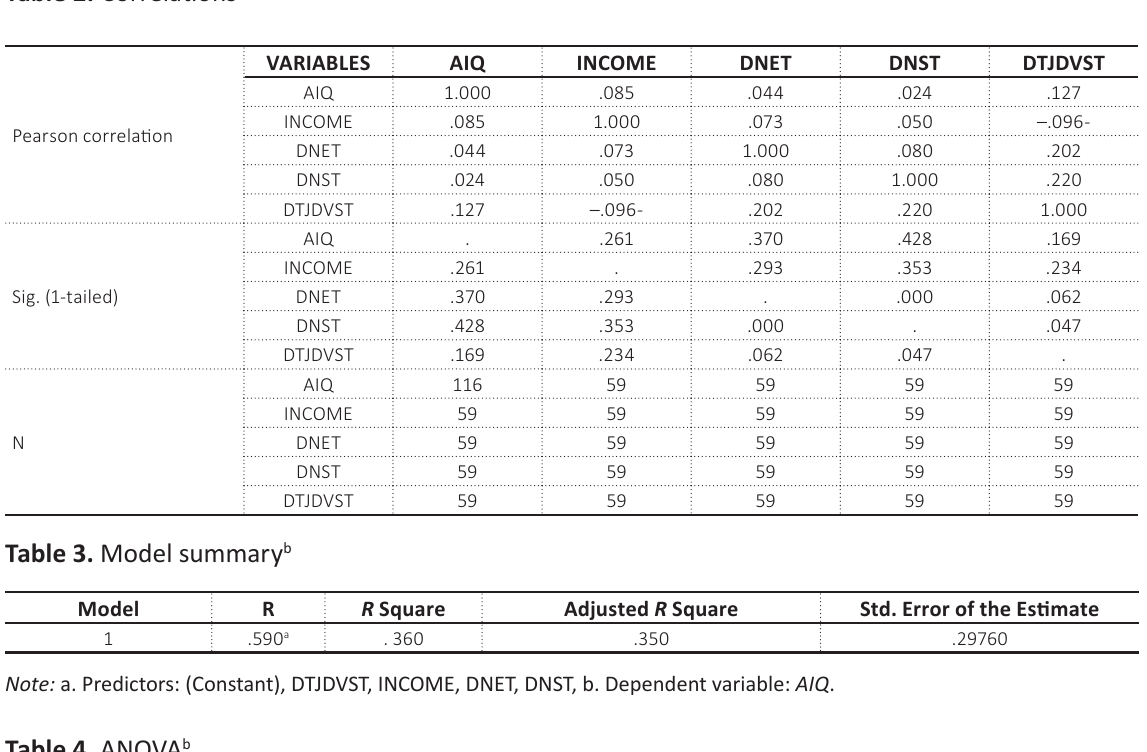
Table 2. Correlations